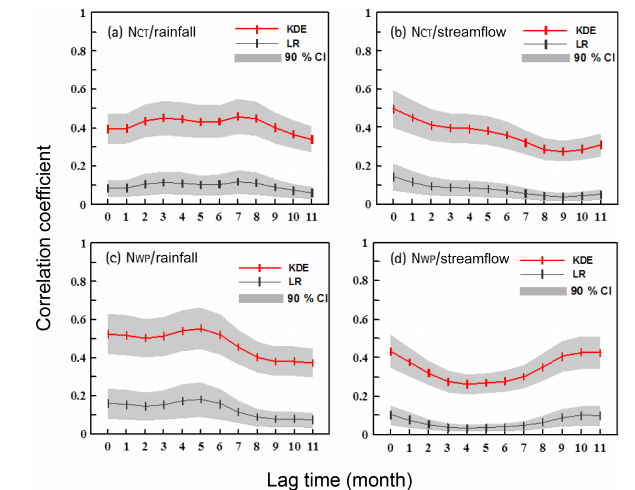
Figure 4. Nonlinear and linear CCs with their 90% confidence bounds between climate index and hydro-meteorological variable in the Korean Peninsula, using KDE and LR approaches, respec- tively. The confidence bounds are given by 5 and 95% quantiles of 1000 bootstrap